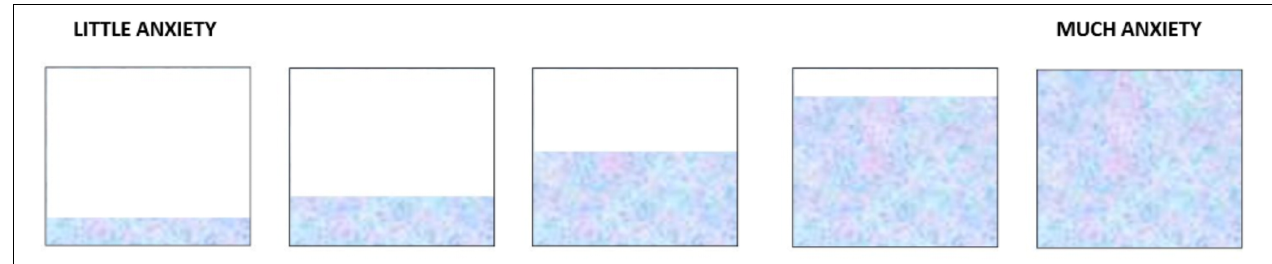
FIGURE 1 | The rating scale used to measure the level of anxiety elicited by each situation described by the items of the EES-AMAS. Children had to respond by pointing at the appropriate box.